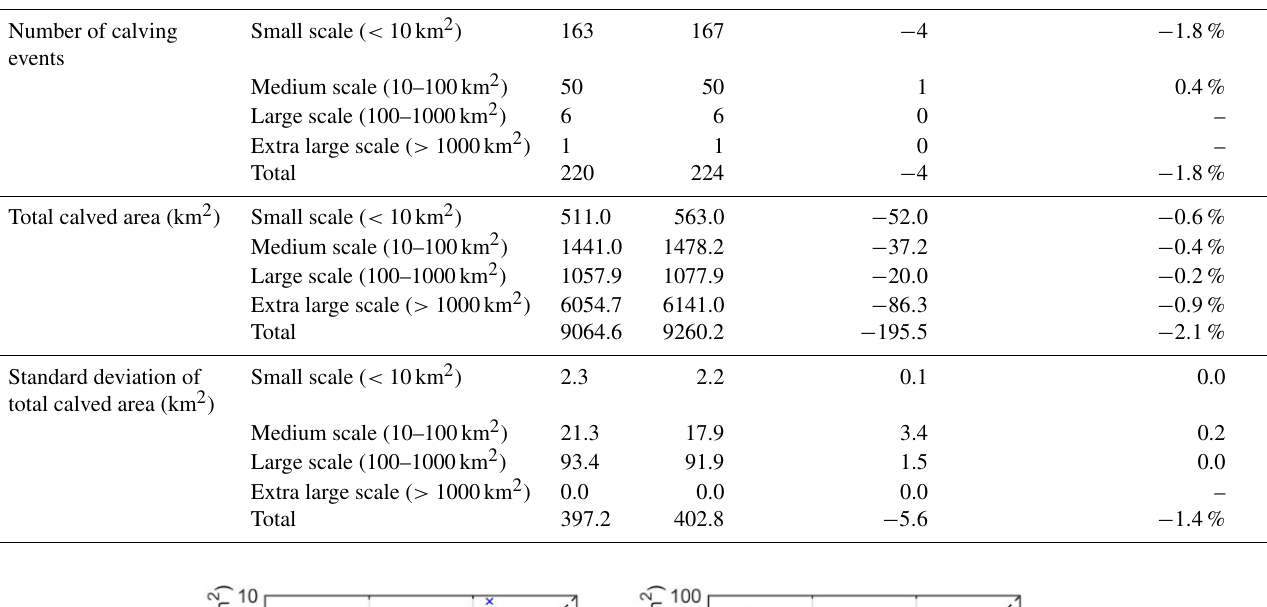
Table 4. Frequency and area distribution of different-scale calving events derived from MODIS and SAR for 2016/2017. Scale MODIS SAR (cid:49) (MODIS − SAR) / SAR Total Number of calving